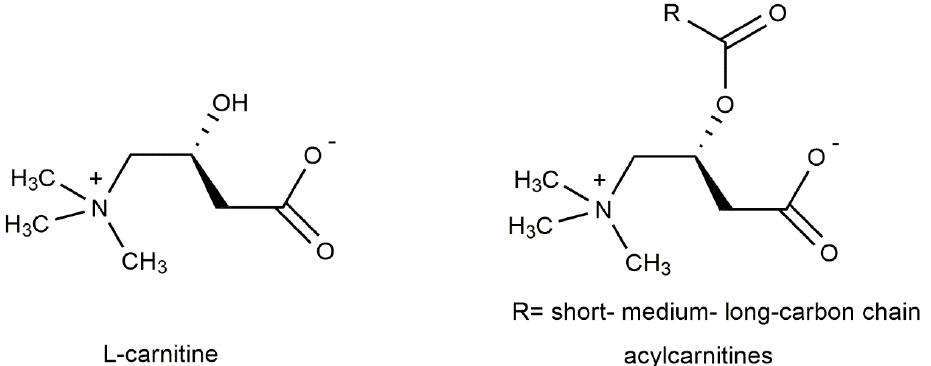
Figure 1. Chemical structures of L-carnitine and acylcarnitines.